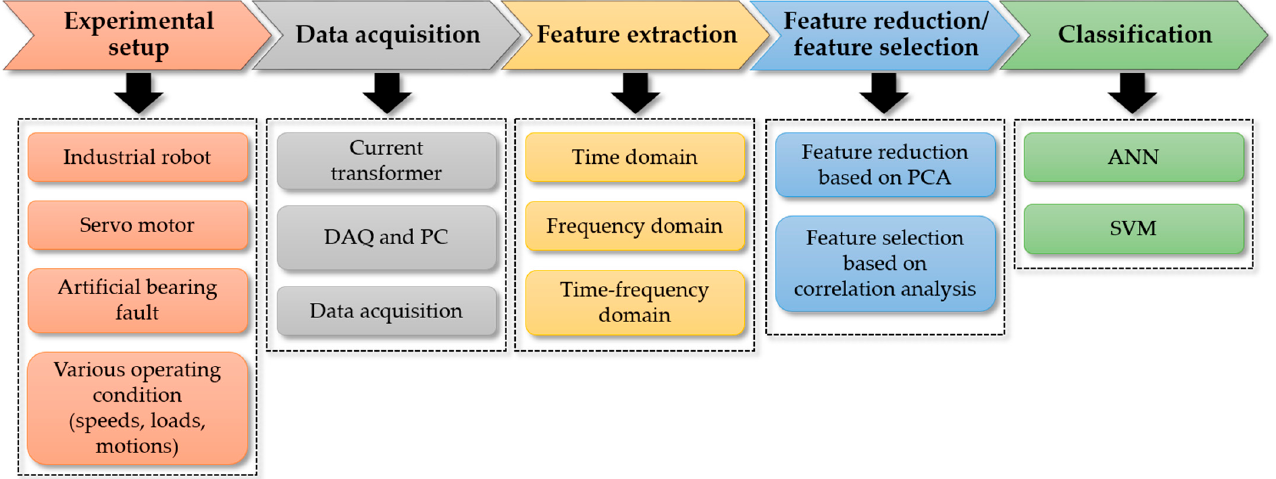
Figure 1. Flow chart of the proposed method.